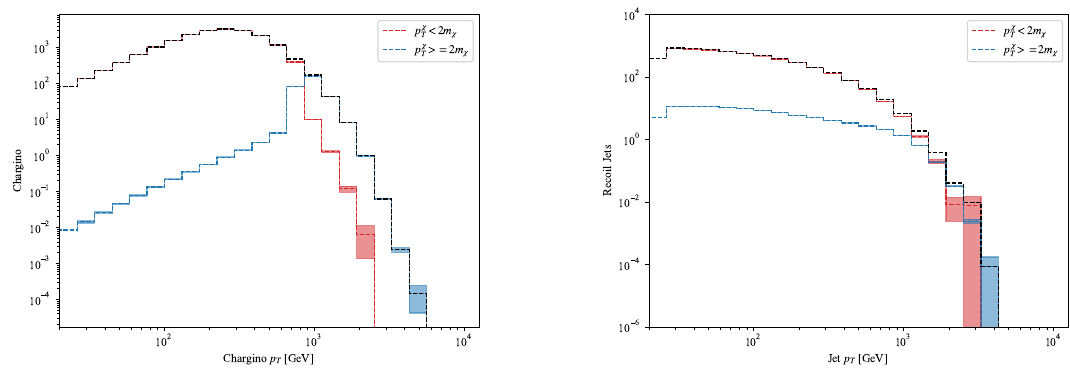
Figure 2 . The p T spectrum of the chargino (left panel, truth level) and hardest jet (right panel, including detector energy resolution), where we show separately the contributions and the uncer- tainties of the two samples generated with p T < 2 m (in red) and p T ≥ 2 m (in blue) at the χ ± χ ± generator level, and combined to get the total spectrum (black dashed). In the left panel, the high p T sample dominates the chargino p T spectrum above 1 TeV, whereas the jet p T spectrum is not well correlated with the chargino p T , and therefore both p T samples contribute even at the highest bins of the right